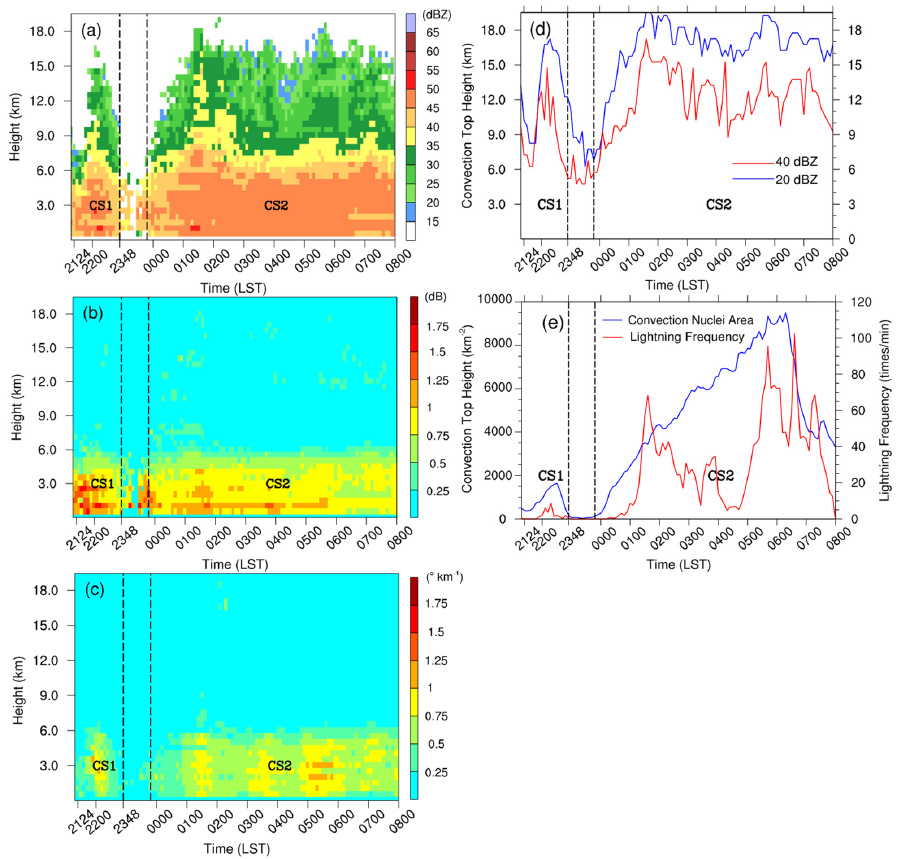
Figure 7. The time–height distributions of ( a ) Z H (unit: dBZ), ( b ) Z DR (unit: dB), and ( c ) K DP (unit: ° ∙ km − 1 ) averaged over the CS CCs. The black dashed lines in ( a – c ) mark the time to separate the two stages for the CS CCs. ( d ) Height map of convection echo. The green line represents the level of 20 dBZ. The red line represents the level of 40 dBZ. ( e ) Convective area and lightning frequency. The green line represents the convective area. The red line represents the lightning frequency.